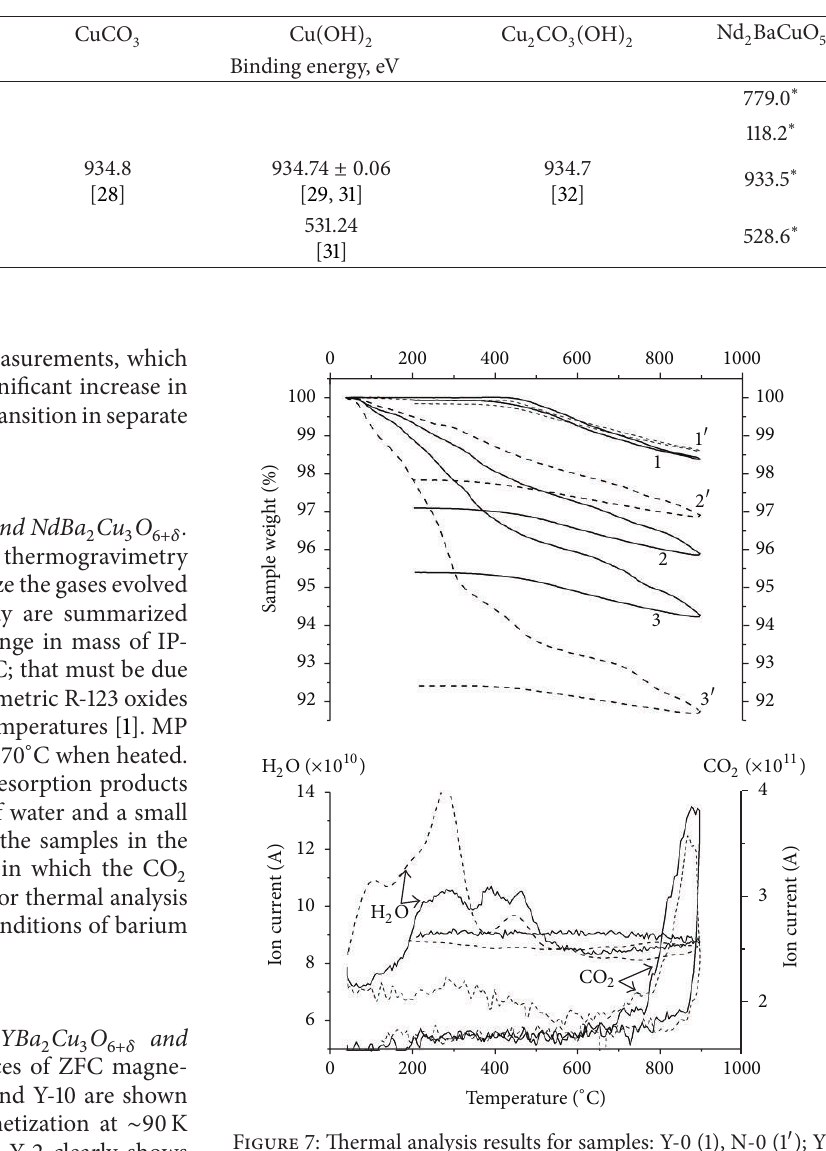
Table 3: Characteristic spectral parameters of different copper compounds.